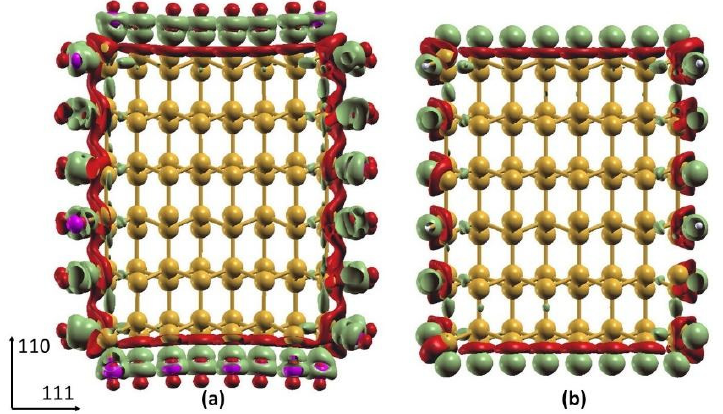
Figure 5. Isosurface of differential charge density of ( a ) Cl-SiNW and ( b ) H-SiNW (mustard color: Si atoms; white: H atoms; magenta: Cl atoms). Green and red regions indicate charge accumulation and depletion, respectively. The isosurface value is set to 0.005.